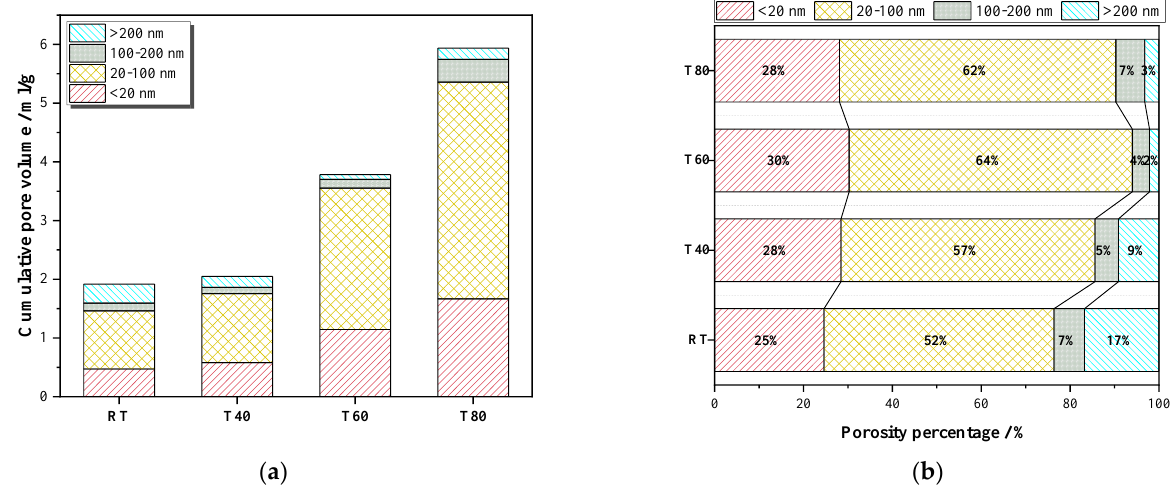
Figure 12. Pore distribution of mortars at 28 days: ( a ) pore volume distribution diagram, ( b ) pore distribution ratio dia- gram.